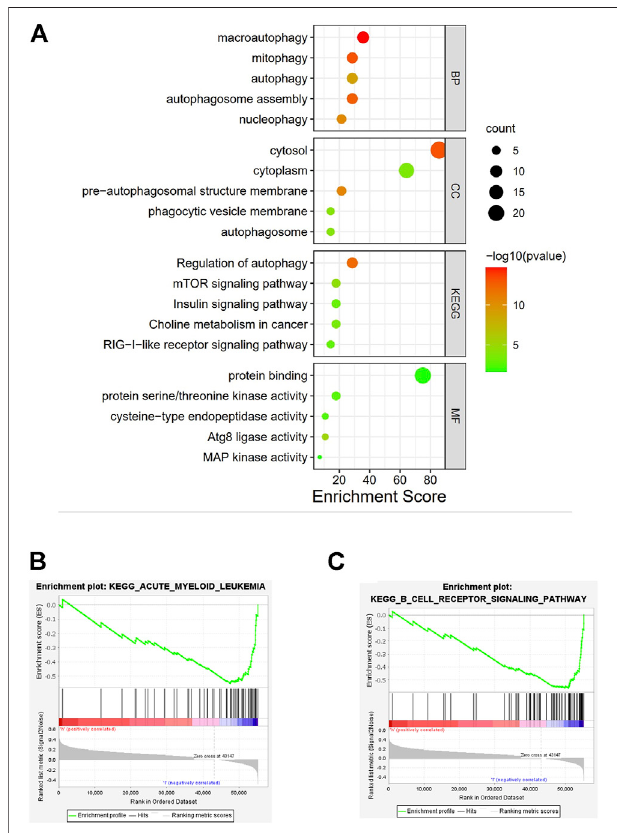
FIGURE 6 | (A) : GO analysis of the risk model. (B,C) : KEGG pathway enrichment of the risk